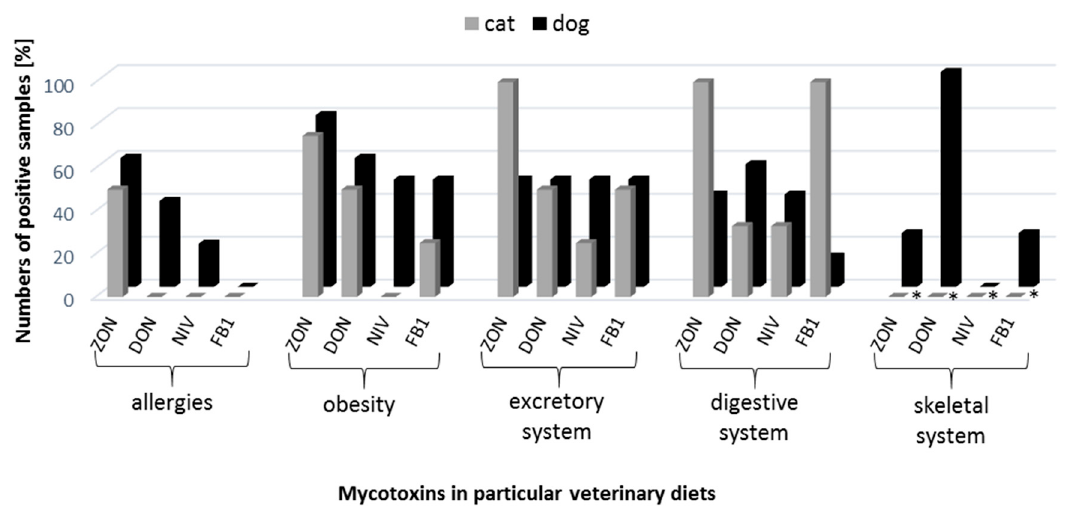
Figure 2. Number of positive samples [%] containing mycotoxins present in veterinary diets for dogs and cats. * there were no diets for cats present in this group.